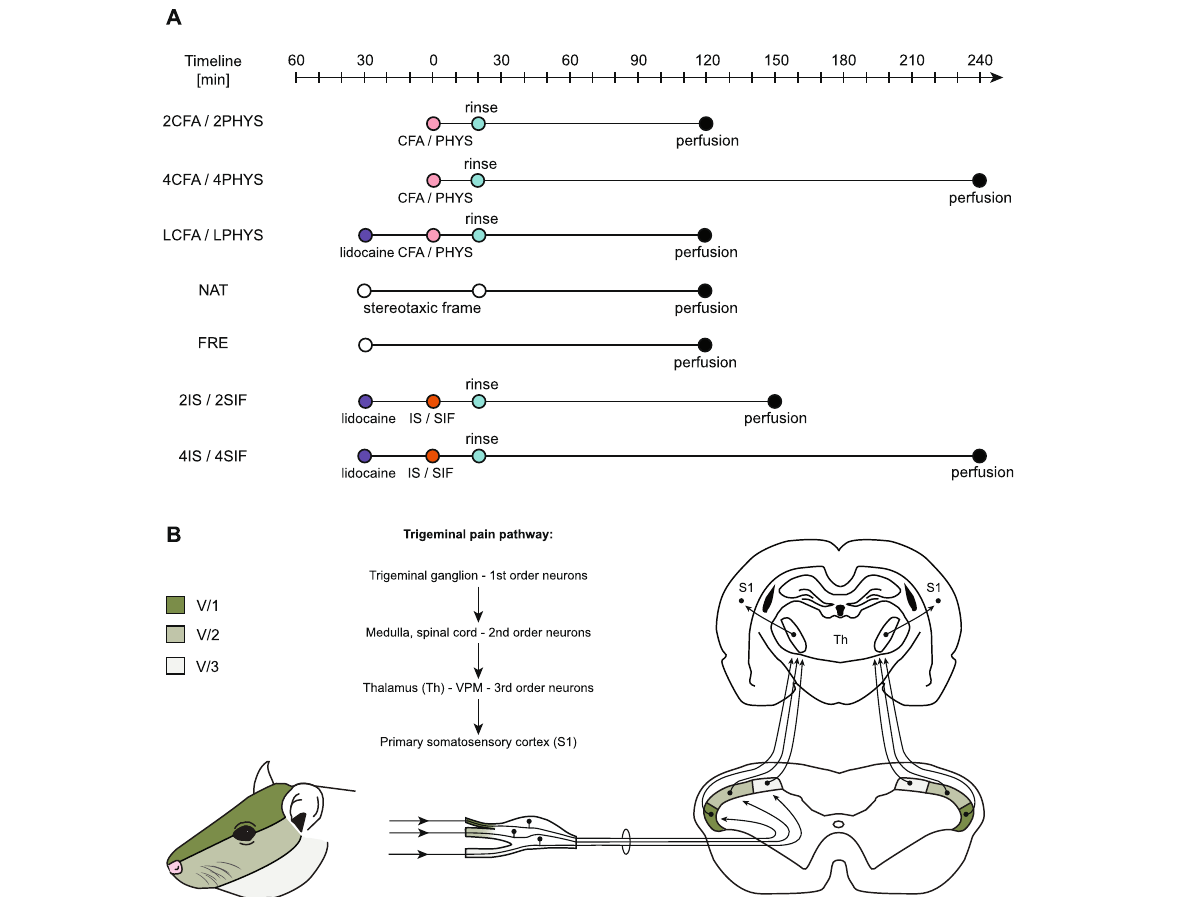
Fig. 1 a : Schematic timeline of the experimental design. The CFA/saline/IS/SIF treatment was considered as “ 0 ” timepoint. LCFA, LPHYS, 2IS, 2SIF, 4IS, 4SIF groups received lidocaine before the skin incision. 20 min after dural treatment, the surface of the dura was rinsed off with either saline or SIF. Animals in NAT and FRE groups were only anesthetized and placed in a stereotaxic frame (NAT) or left on a heating pad (FRE) as long as animals in other groups. b : Schematic figure of trigeminal pain pathway. Dermatome distribution of the trigeminal nerve divisions of the face. Trigeminal ganglion contains the first-order neurons, second-order neurons are found in the spinal cord and medulla. Schematic figure of the dorsal horn shows the somatotopic representation of the three branches of the trigeminal nerve. The ventral (darkest), intermediate and dorsal part of the dorsal horn considered to be equivalent to the area of the ophthalmic (V/1), maxillary (V/2), and mandibular (V/3) branch. Figure of the coronal brain section represents the third-order neurons in the thalamus (Th) and neurons in the primary somatosensory cortex